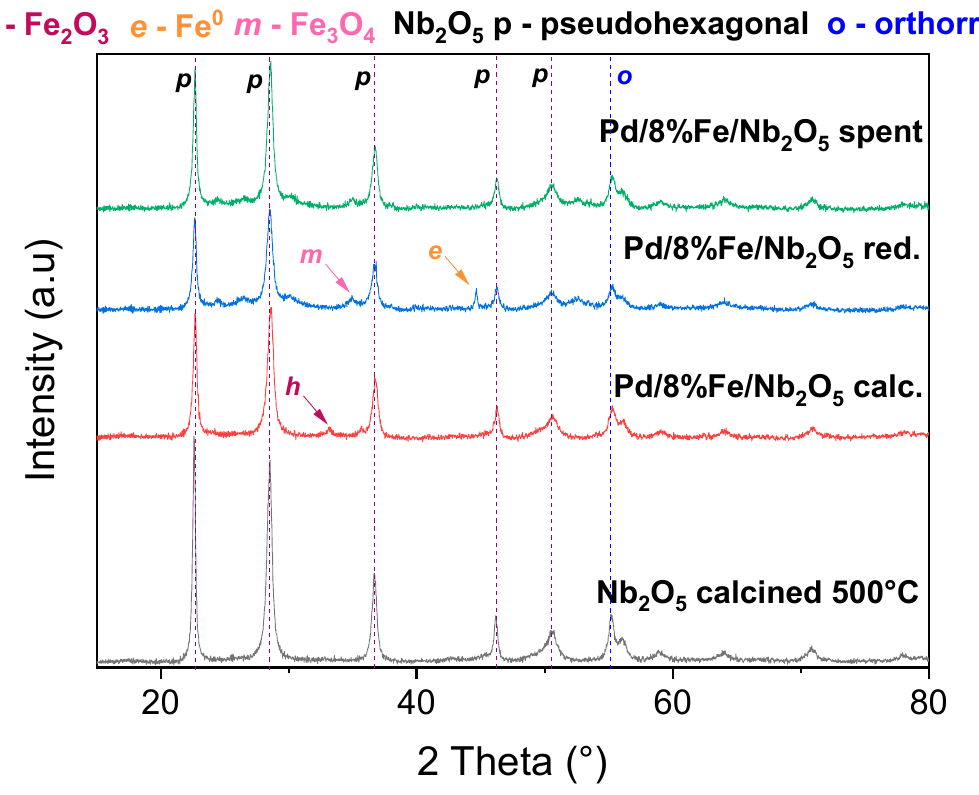
Figure 14. XRD-diffractogram of calcined Nb 2 O 5 support and Pd/8%Fe/Nb 2 O 5 after calcination, after reduction under H 2 and after the HDO.